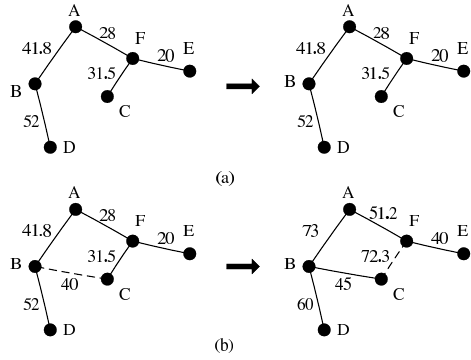
Figure 1. ( a ) Static shortest path tree, with the Euclidean distance between sensor nodes as the edge weight; ( b ) dynamic shortest path tree, with the Euclidean distance between the sensor nodes and the residual energy as the edge